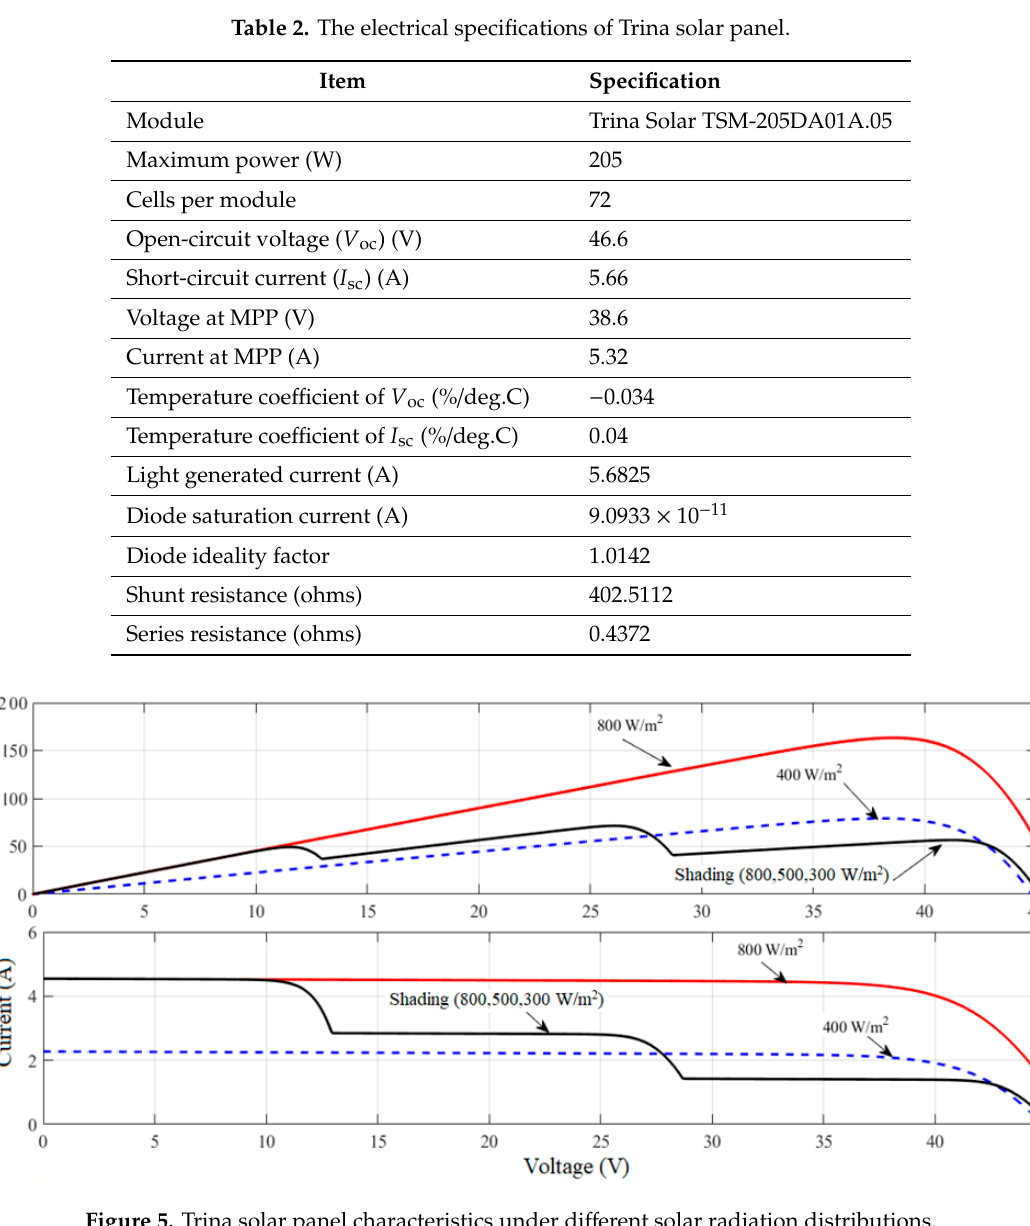
Figure 5. Trina solar panel characteristics under different solar radiation distributions.